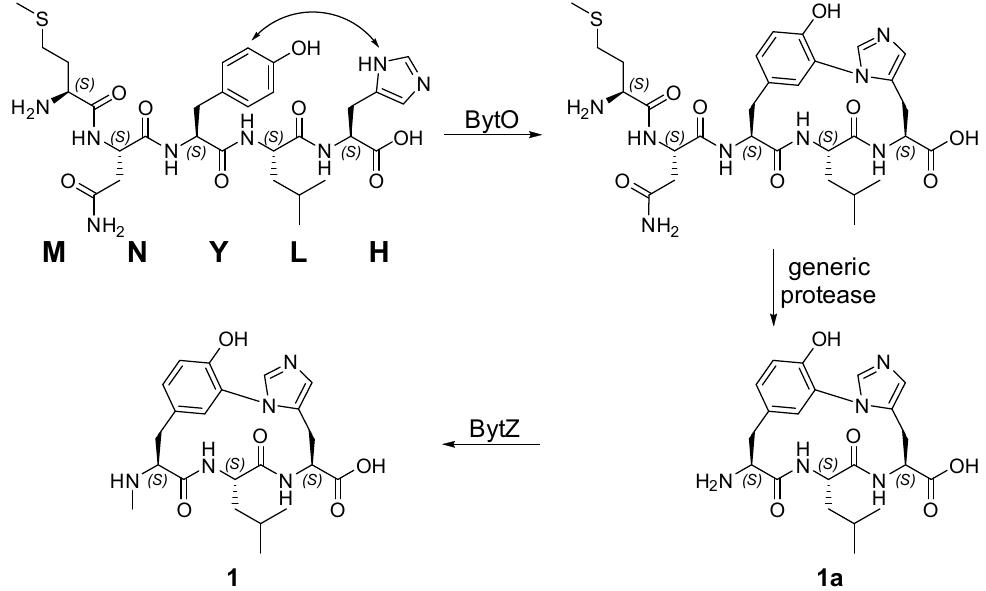
Scheme 2. Proposed biosynthesis of 1 from the ribosomally synthesized precursor peptide MNYLH.